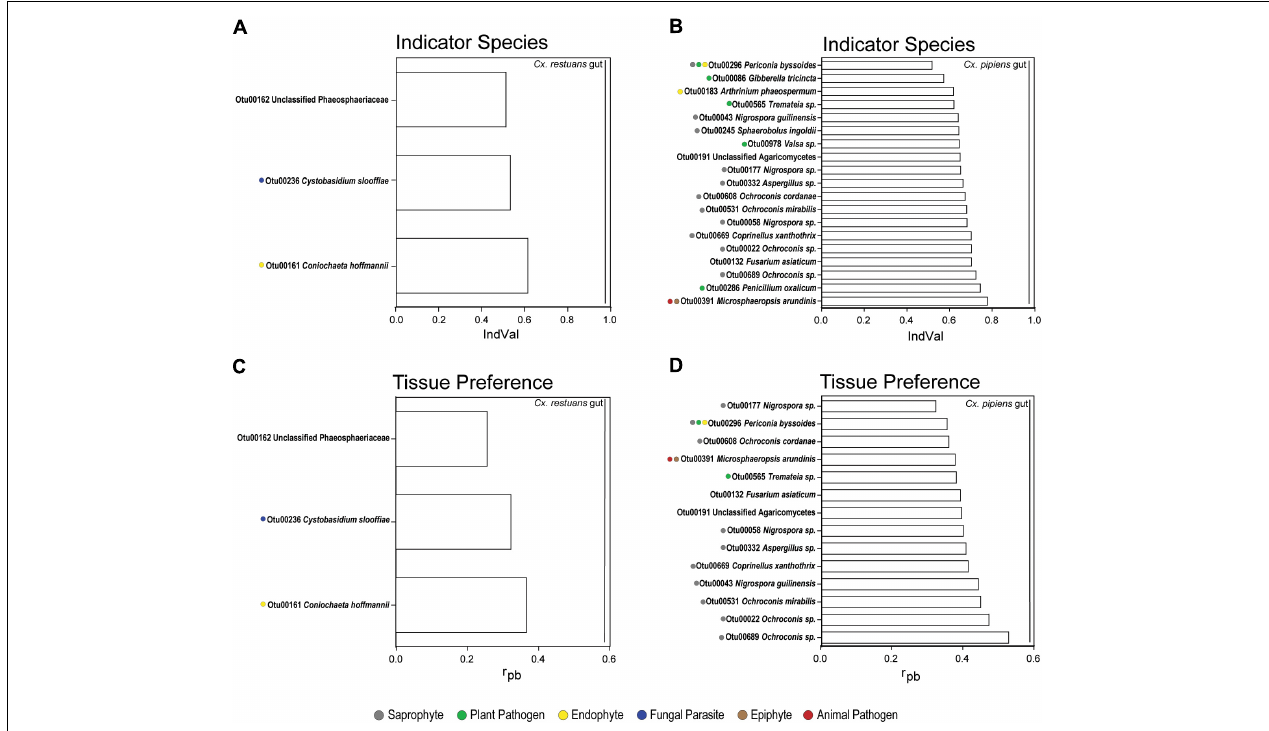
FIGURE 6 | Indicator species analysis using indicator value index (IndVal) and point-biserial correlation index ( r pb ) of fungal OTUs identified in mosquito guts and carcasses across all breeding sites. (A) IndVal analysis of Cx. restuans gut indicator OTUs. (B) IndVal analysis of Cx. pipiens gut indicator OTUs. (C) OTU tissue preference across Cx. restuans guts and carcasses using r pb analysis. (D) OTU tissue preference across Cx. pipiens guts and carcasses using r pb analysis. Statistical significance is measured at P -value of 0.05 and with 9,999 permutations. Ecological guilds of each OTU identified using the FUNGuild annotation tool are presented by color coded solid